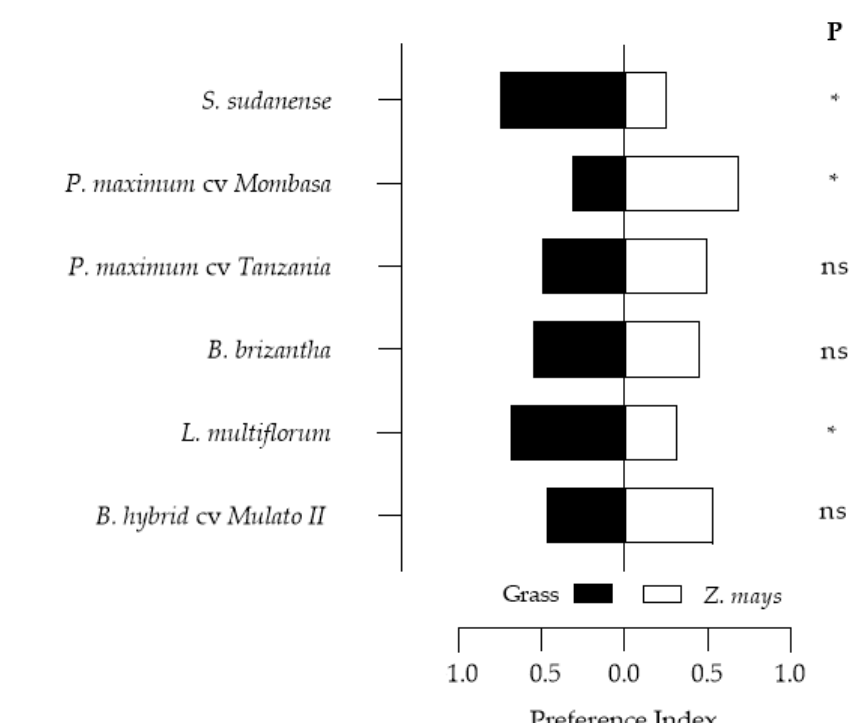
Figure 7. Feeding preference indices of S. frugiperda larvae in two-choice tests. * p < 0.05 (significant difference), ns = no significant difference.